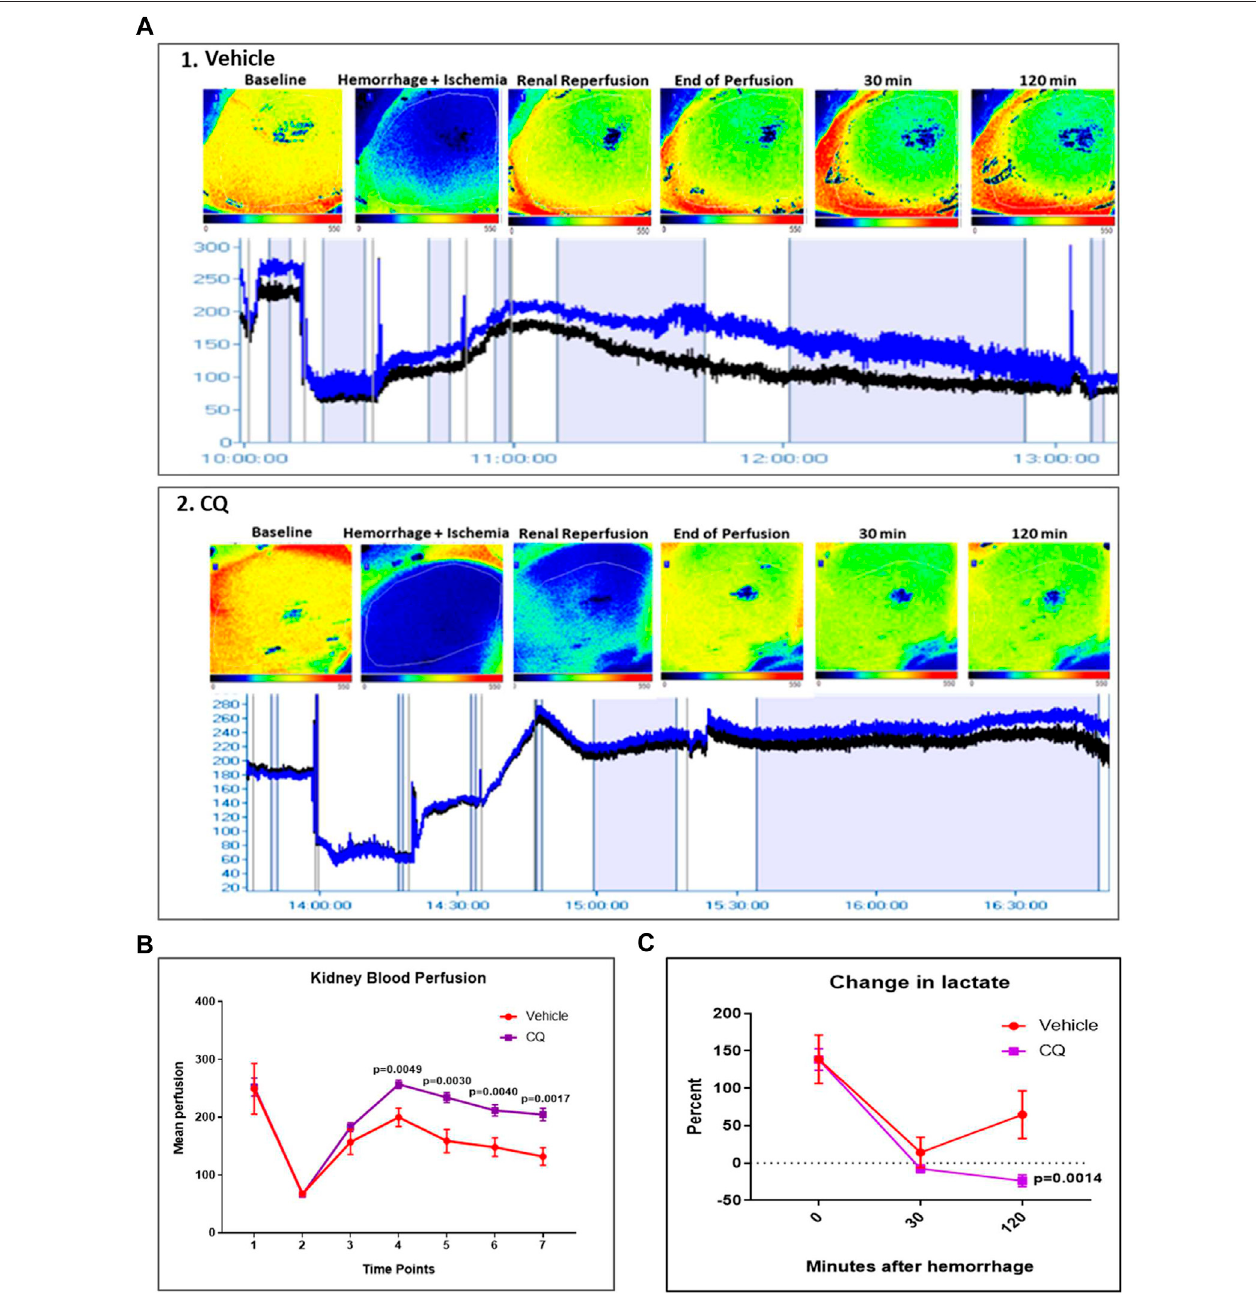
FIGURE2| EffectofCQonkidneyblood fl owinaratmodelofkidneyischemia/reperfusionwithhypovolemicshock. (A) ,1and2,representativeimagesofblood fl owin kidneysofvehicle1)andCQ2).Upperpanelin1and2showskidneyimagesobtainedfromPeriCamPSIblood fl owimagingsystem.Redrepresentshighestblood fl owand bluerepresentsthelowest.Thelowerpanelsin1and2showtheblood fl owgraphs – Bluelineindicatesblood fl owincompleteimagedarea,Blacklineindicatesblood fl owin the kidney. N (cid:1) 7 for vehicle and N (cid:1) 8 for CQ. (B) , a graphicalrepresentationofkidneyblood fl owatdifferent time points(1 – baseline,2 – after hemorrhage,3 – after de- clamping renal arteries, 4 – 0 min post-perfusion, 5 – 30 min post-perfusion, 6 – 90 min post-perfusion and 7 – 120 min post-perfusion). Data represents mean ± SEM values. (C) ,thegraphrepresentspercentchangeinbloodlactatelevelsinCQandvehicleratsatdifferenttimepoints – afterhemorrhage(0 minofresuscitation),at30and120 minof resuscitation. Baseline is indicated with dotted lines. Data represents mean ± SEM values. N (cid:1) 7 for vehicle and N (cid:1) 8 for CQ. Statistical analysis – unpaired t -tests.